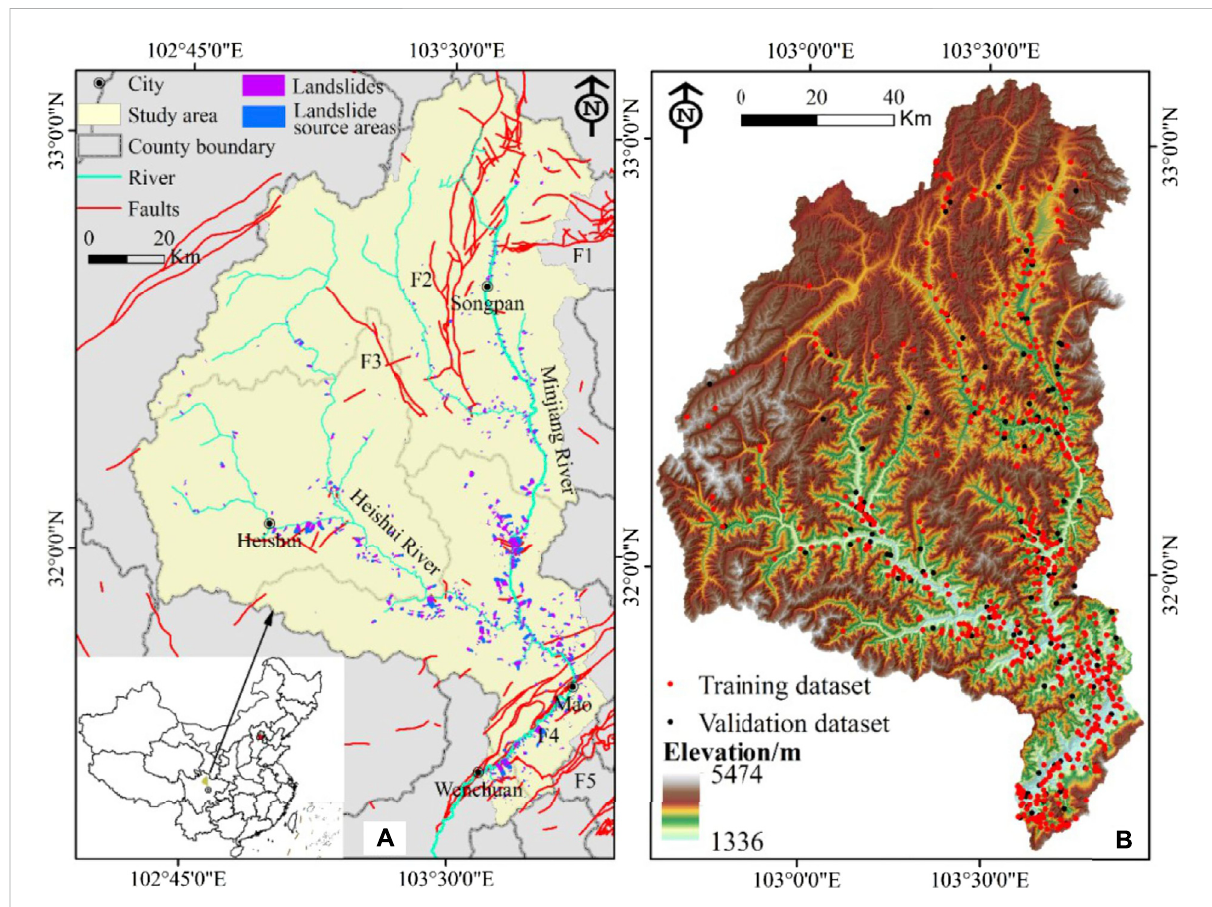
FIGURE 1 Geography map of the study area. (A) The location of the study area. (B) Topography and landslide inventory of the Minjiang catchment. F1: Xueshan faults, F2: Minjiang faults, F3: Songpinggou faults, F4: Yingxiu-Beichuan faults, F5: Maoxian-Wenchuan